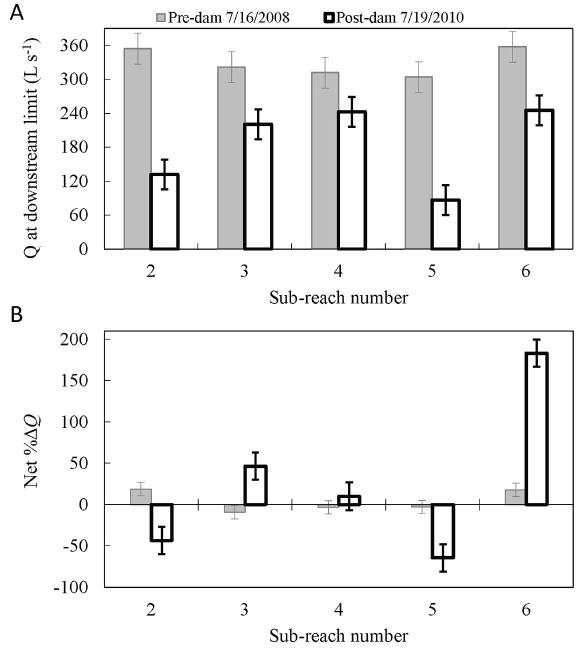
Figure 8. Sub-reach stream discharge ( Q ) estimates for 2008 and 2010 representing longitudinal flow variability before and after beaver colonization. % (cid:49)Q is calculated from flow at the end of the sub-reach minus the flow at the beginning of the sub-reach relative to the upstream